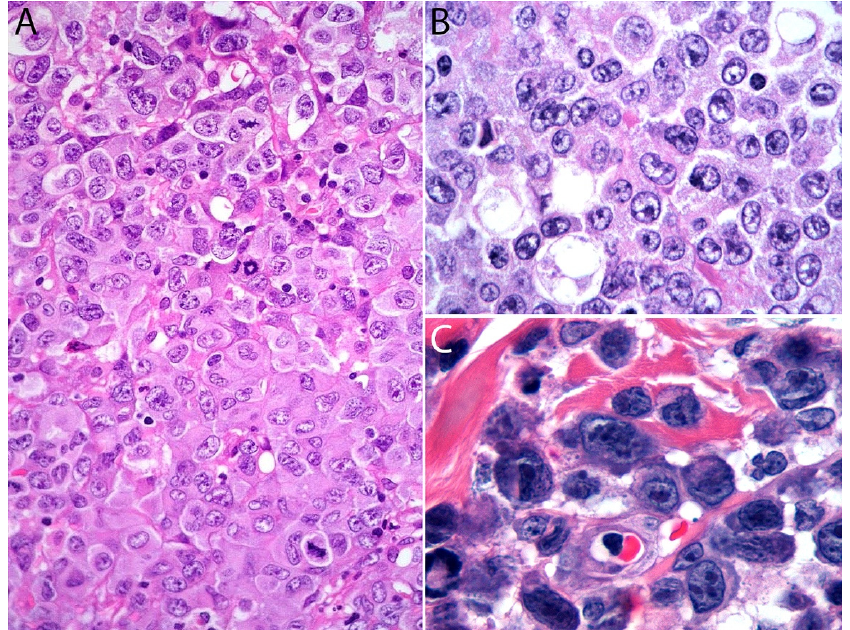
Figure 12. ( A – C ). Primary cutaneous ALCL is composed of sheets of medium to large neoplastic lymphoid cells with anaplastic features.